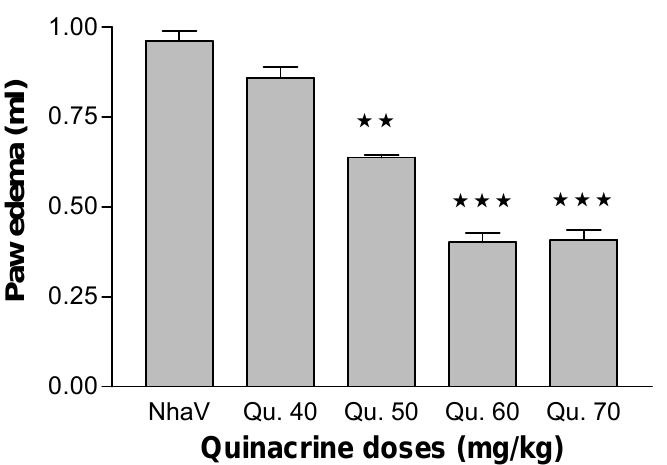
Figure 2: Effect of quinacrine (40, 50, 60, 70mg/kg, i.p. administered 30 min before the venom injection) on the rat paw edema induced by NhaV (5µg/paw). The control group received NhaV alone (5µg/paw), instead of drugs, in the same experimental conditions. Each column represents the mean ± S.E.M. of six rats. * p<0.05 (weakly significant); ** p<0.01 (significant); and *** p<0.001 (very significant); (ANOVA and Bonferroni posttest).